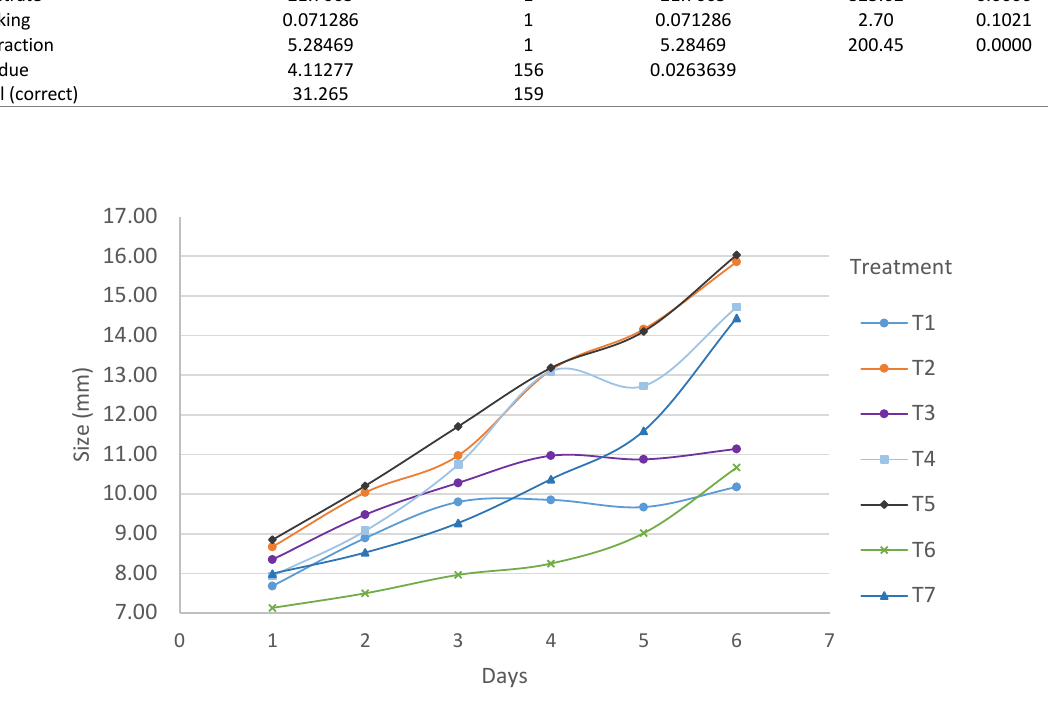
Fig. 2: Size of Hermetia illucens larvae for each treatment over time. Larval growth system (T1: raw beef blood, T2: raw beef viscera, T3: cooked beef blood, T4: cooked beef viscera, T5: control (balanced feed), T6: raw chicken viscera, and T7: cooked chicken viscera). Table 3: ANOVA Hermetia illucens larvae size at day 5